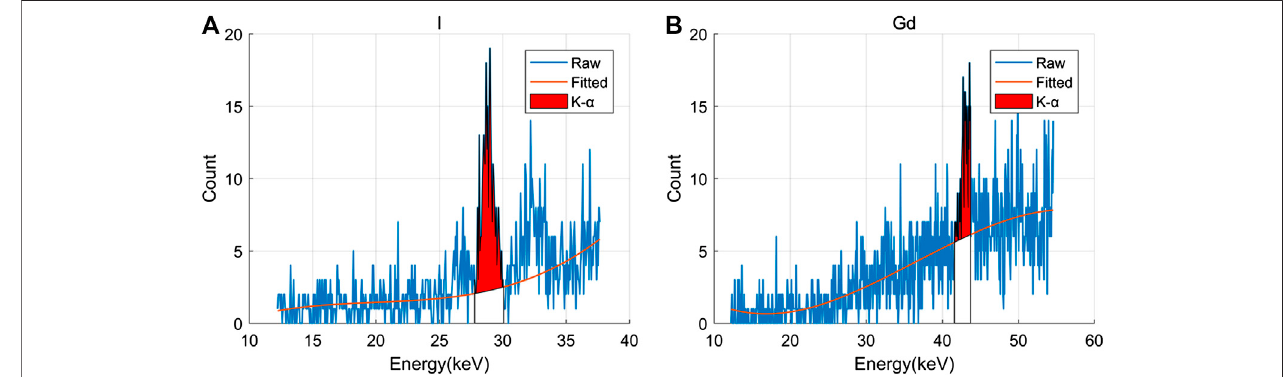
FIGURE 9 | Fitting results of the scattered background in the region of the XRF peak: (A) I; (B) gadolinium (Gd).